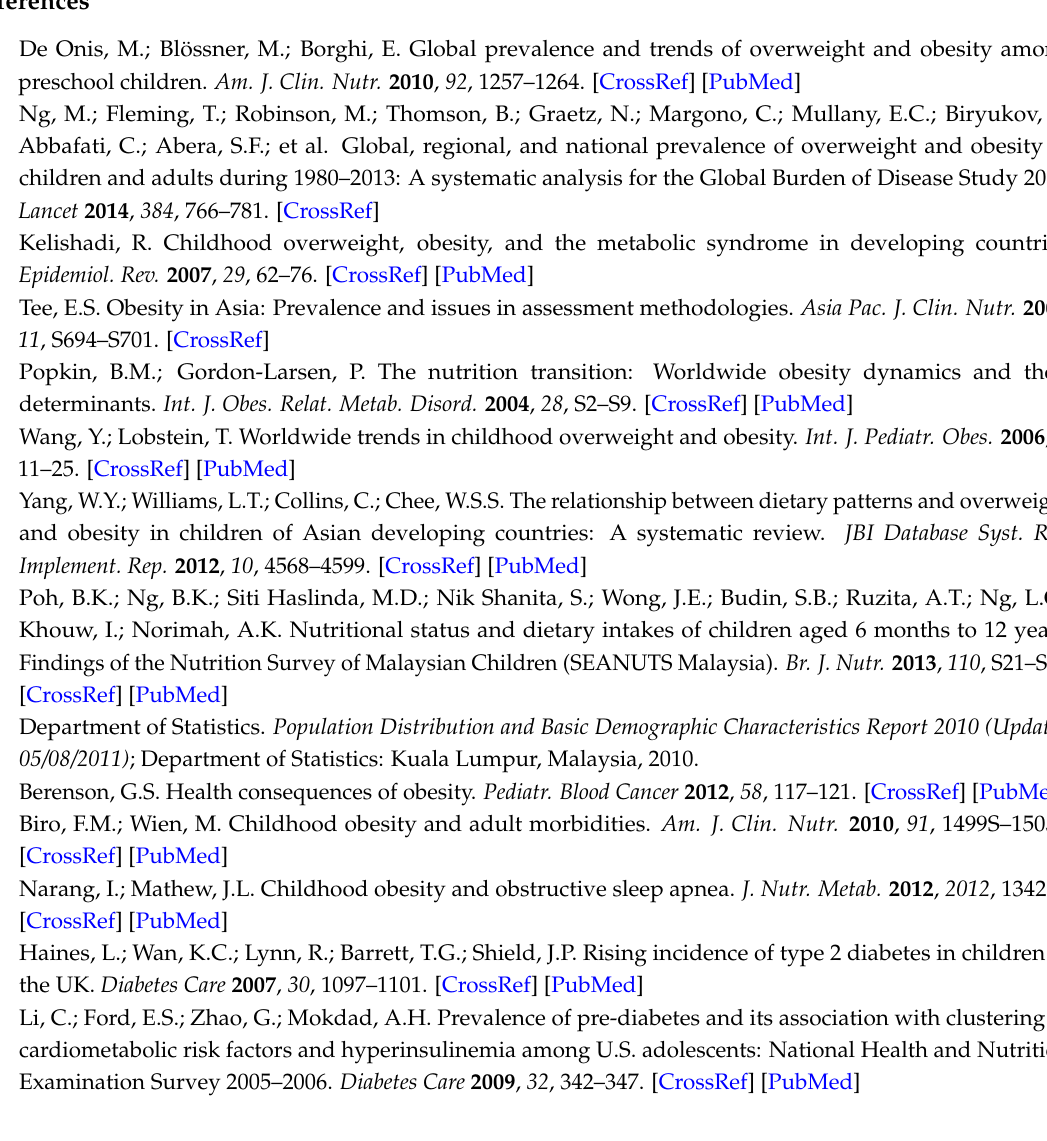
Food grouping scheme; Table S2: Classification of energy misreporting for all children sorted by gender and BMI category; Table S3: Characteristics of children’s dietary intakes (energy, macronutrients, micronutrients, and food